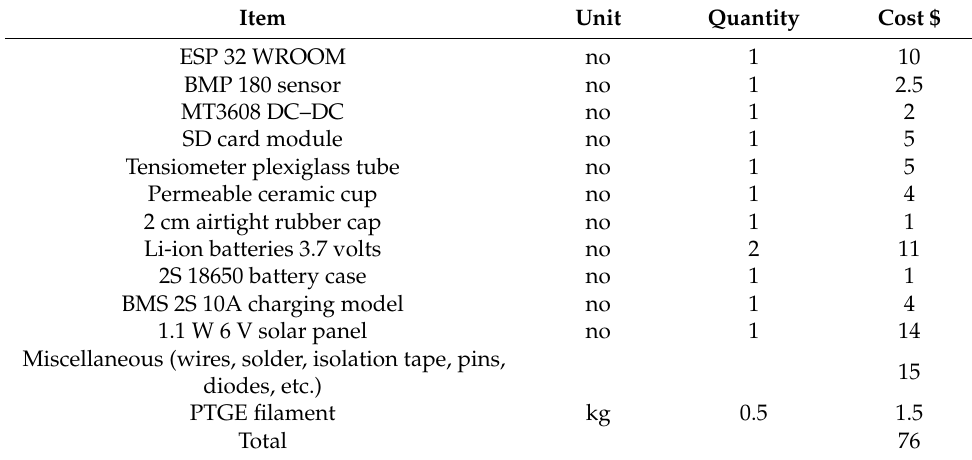
Table 1. Breakdown cost of the